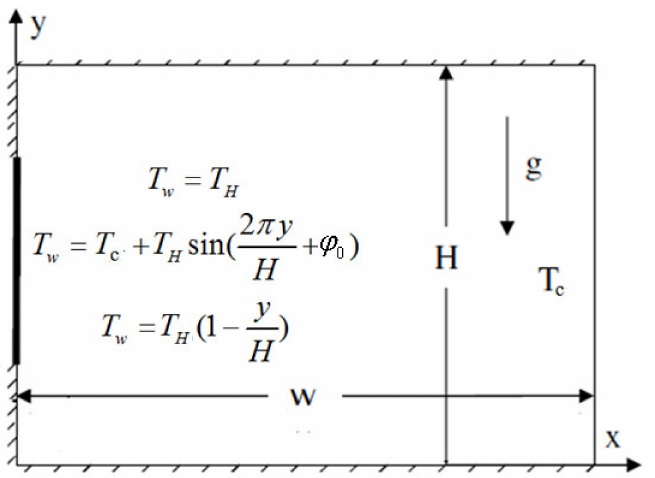
Figure 3. Geometrical